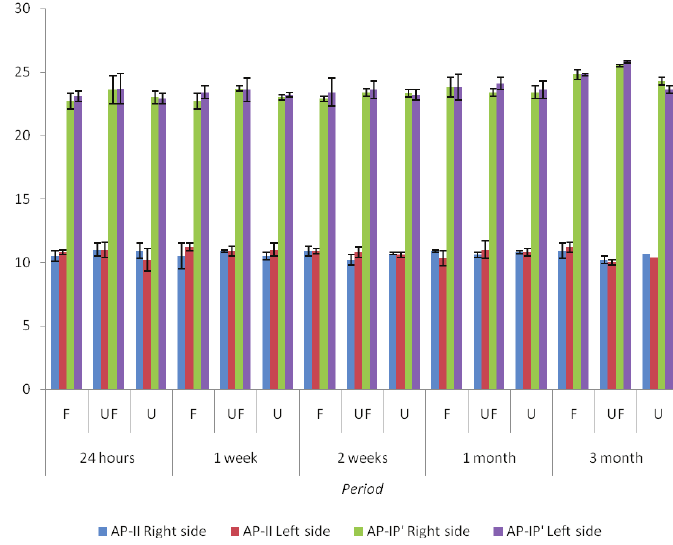
FIGURE 5 – Mean values (mm) of the distances found on the mensurations of the mandible of all the groups according to the experimental period ( AP = angular process, II = insertion of incisor of the mandible, IP = incisal point, F = fracture group, UF = undernourished fracture group, U = undernourished group).